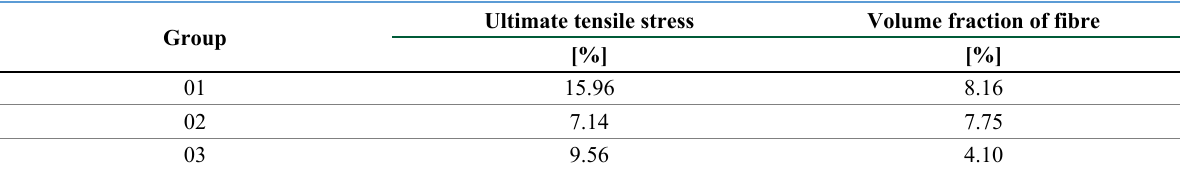
Table 5. Coefficient of variation for Groups 01, 02 and 03: ultimate tensile stress and volume fraction of fibre. Ultimate tensile stress Volume fraction of fibre Group